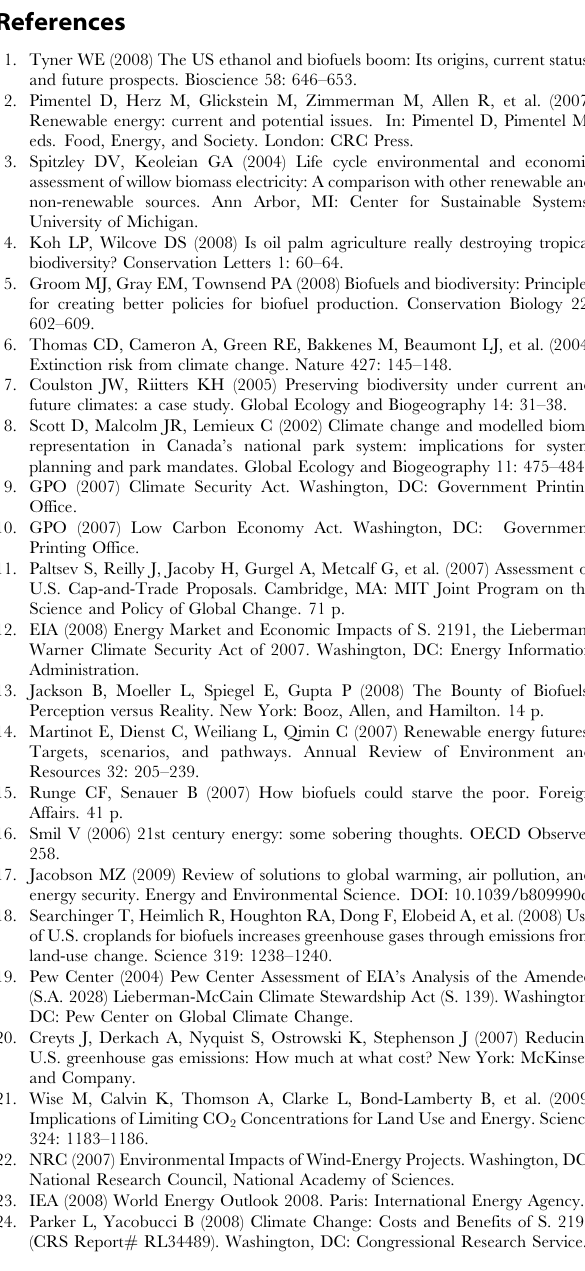
Table S3 Decision criteria for classifying